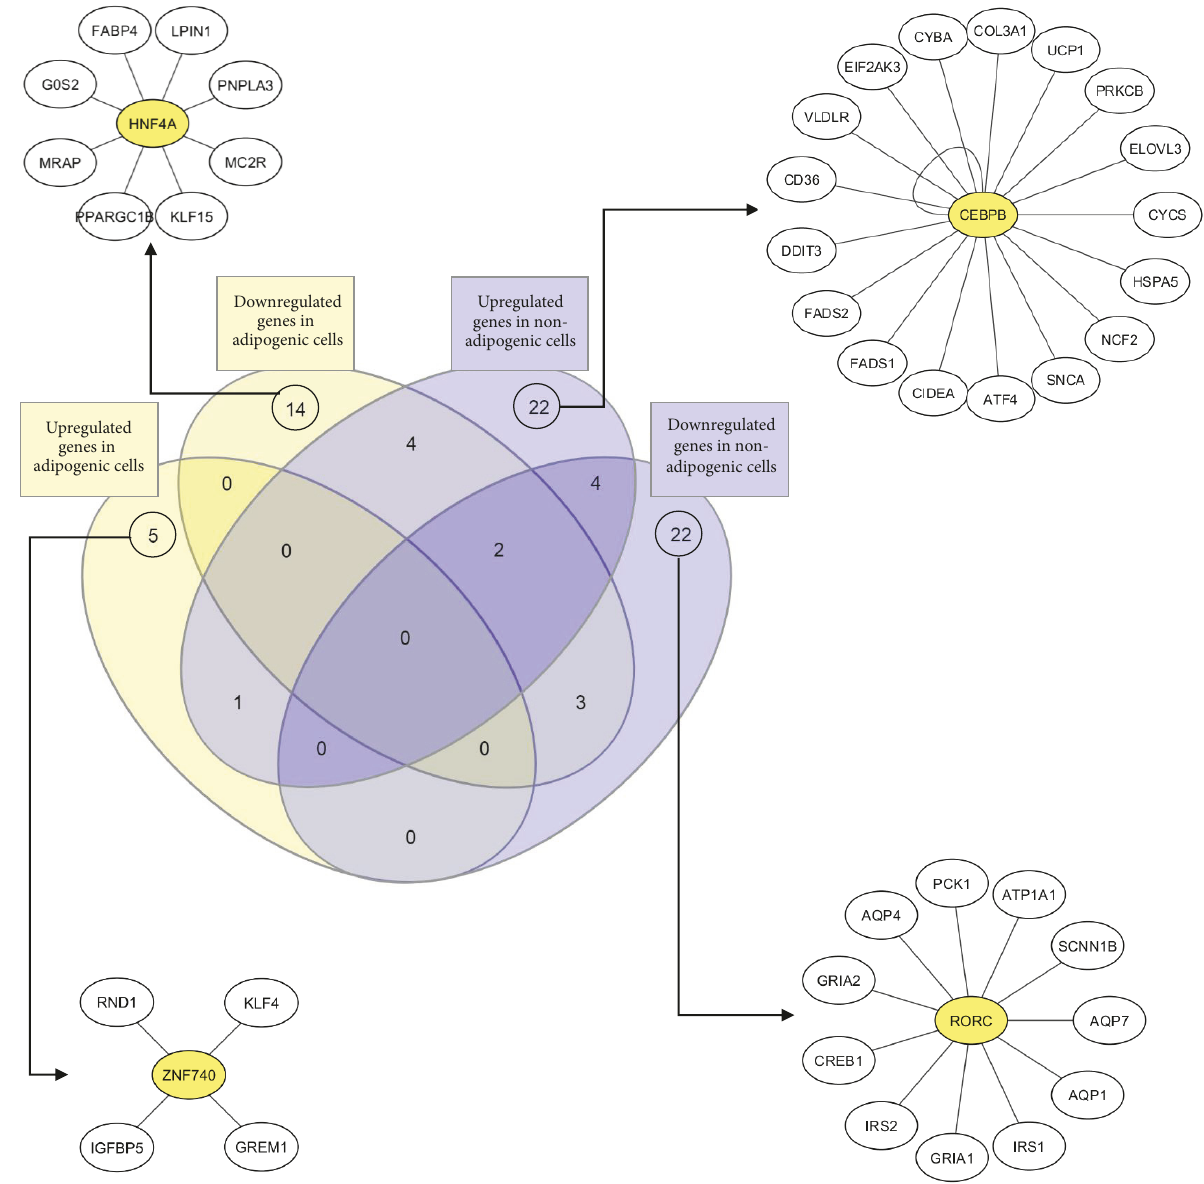
Figure 9: D ifferently expressed genes during seipin loss-of-function . InteractVenn [43] allowed us to see four different clusters formed when seipin loses its function in different cell types. iRegulon [44] shows HNF4A , CEBPB , ZNF740, and RORC as important transcription factors that may interfere with the expression of the observed genes for each cluster. Among them, only CEBPB was studied in a loss of seipin function